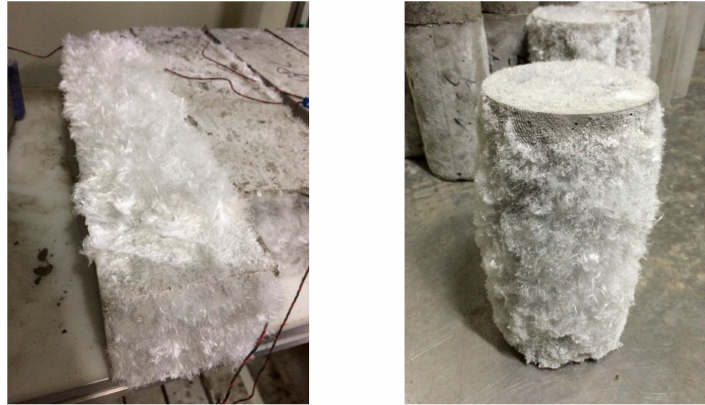
Figure 7. Flow out of urea after hardening of